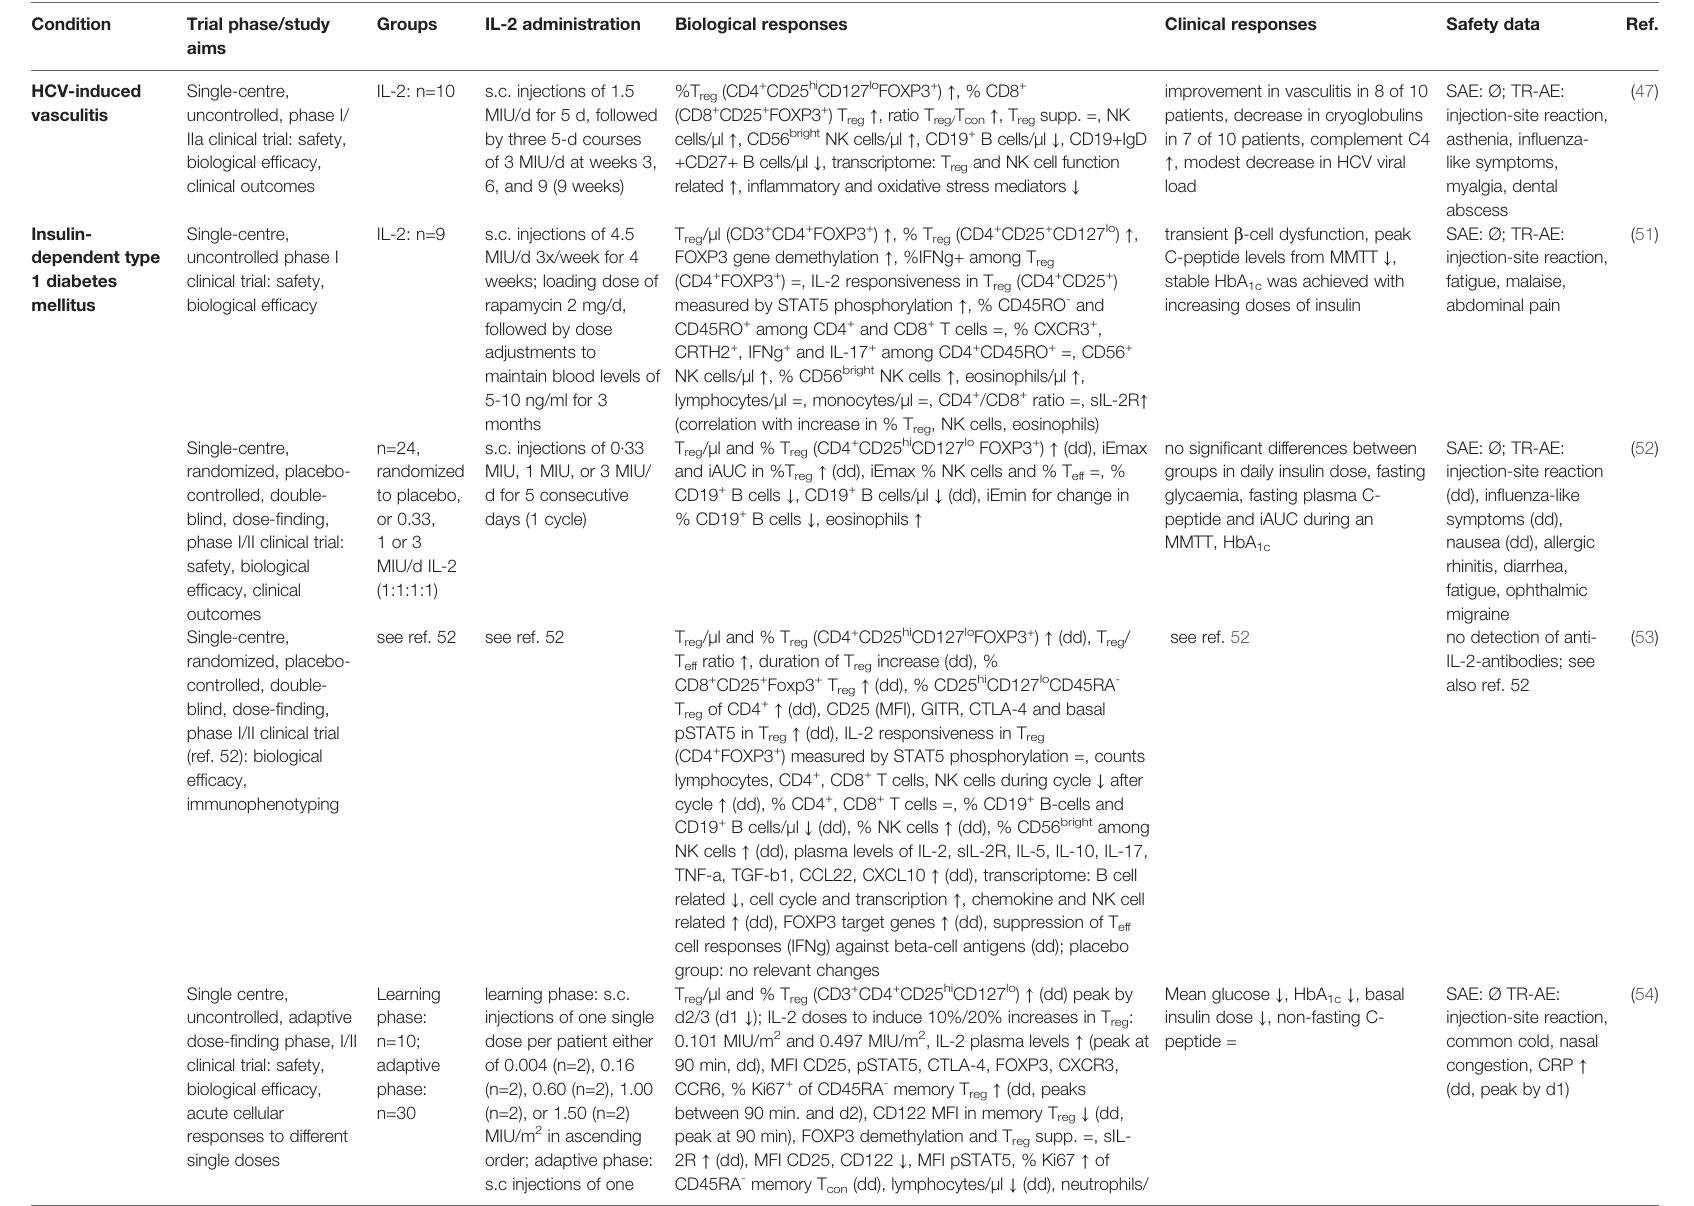
TABLE 1 | Summary of results from clinical studies with low-dose IL-2 therapy in autoimmune and rheumatic diseases.